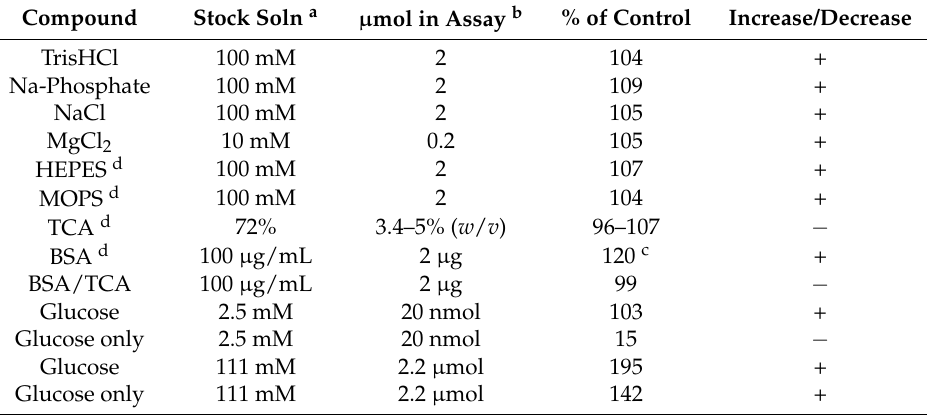
Table 1. The effect of commonly used buffers and salts upon the modified Kulka assay. Compound Stock Soln a µ mol in Assay b % of Control Increase/Decrease TrisHCl 100 mM 2 104 + Na-Phosphate 100 mM